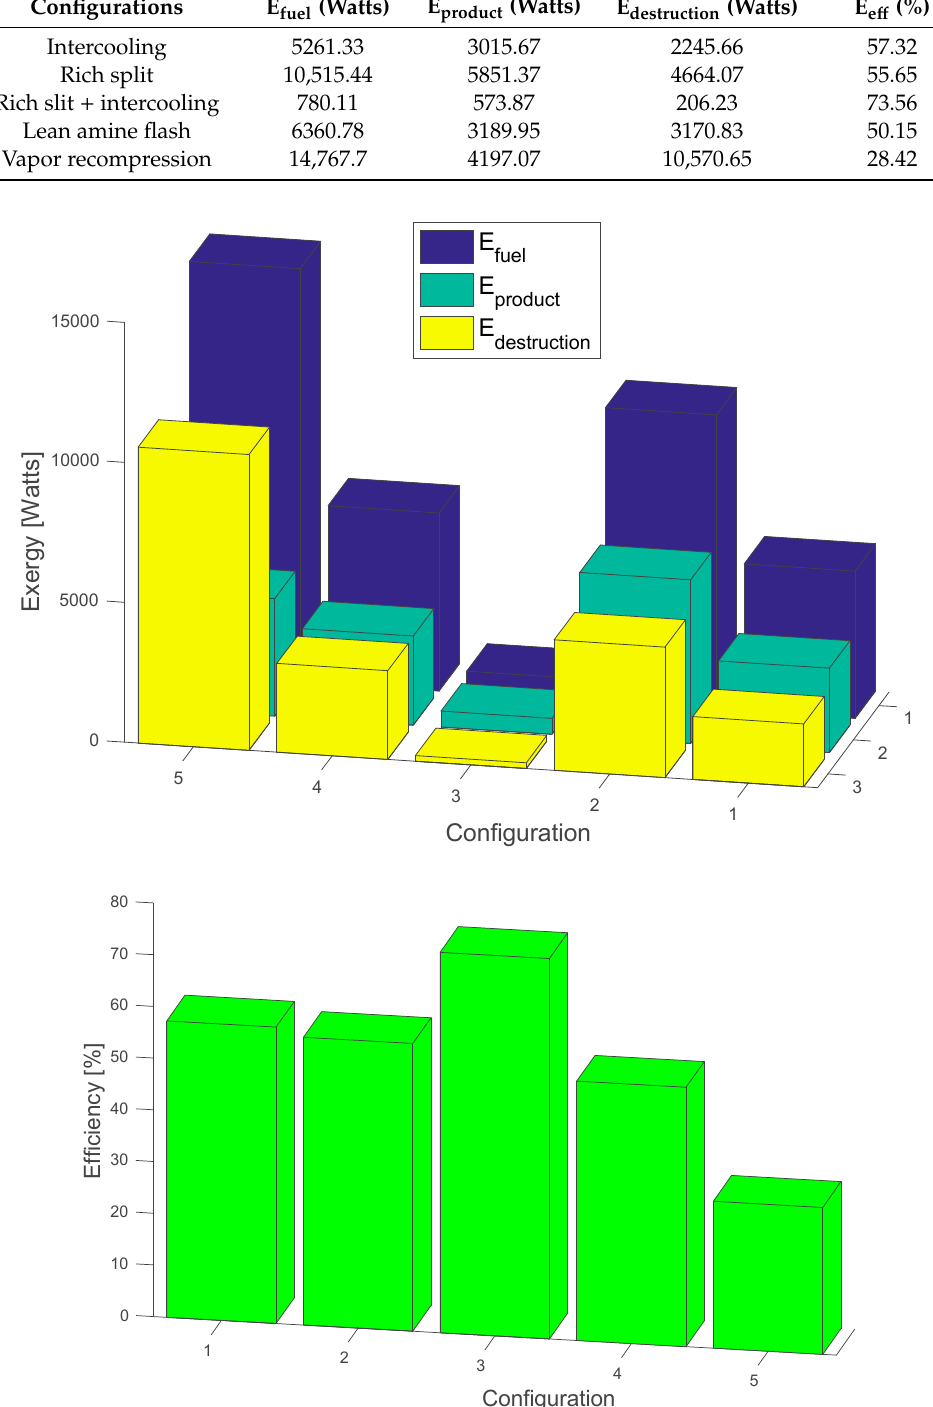
Figure 6. Summary Results of Exergy Analysis for the Different Configurations. For the horizontal “Configuration” axis, 1. Intercooling 2. Rich Split 3. Rich Split with Intercooling 4. Lean Amine Flash 5. Vapor Recompression.